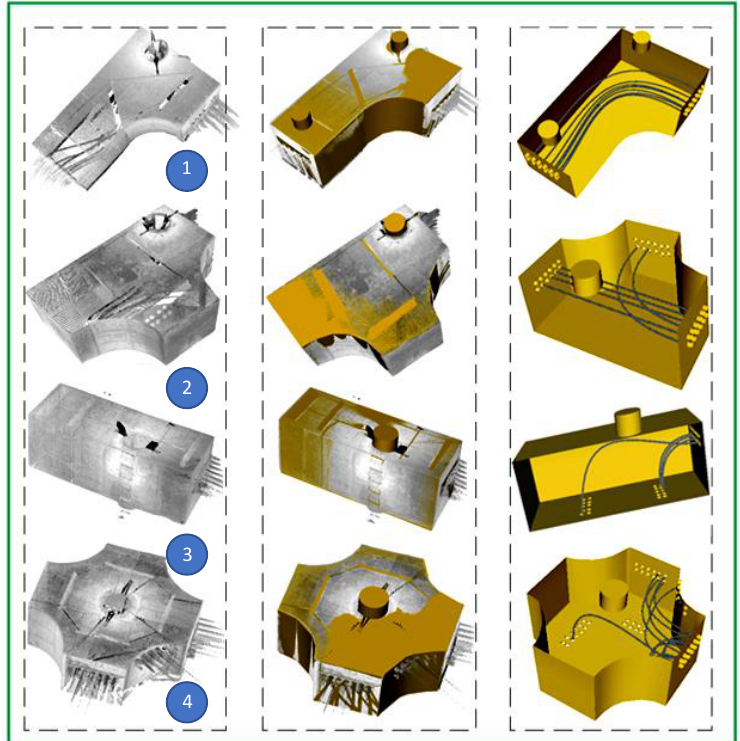
Figure 14. Construction of different cable well models. ( left ) Original point clouds, ( middle ) generated cable well models, and ( right ) cable and pipe hole models.